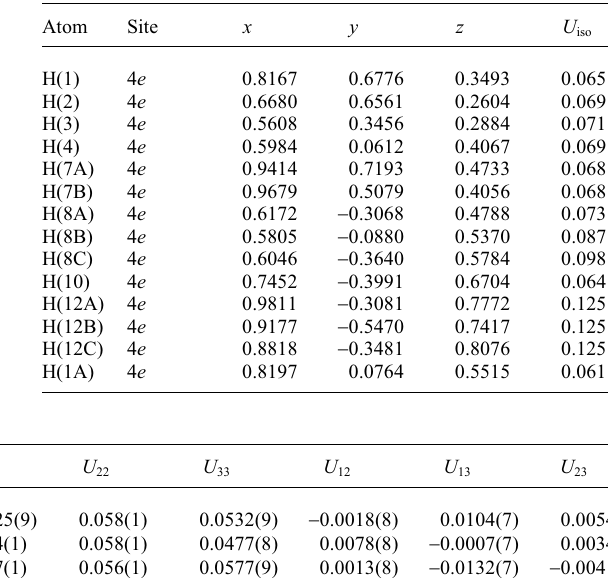
Table 2. Atomic coordinates and displacement parameters (in Å 2 ) .